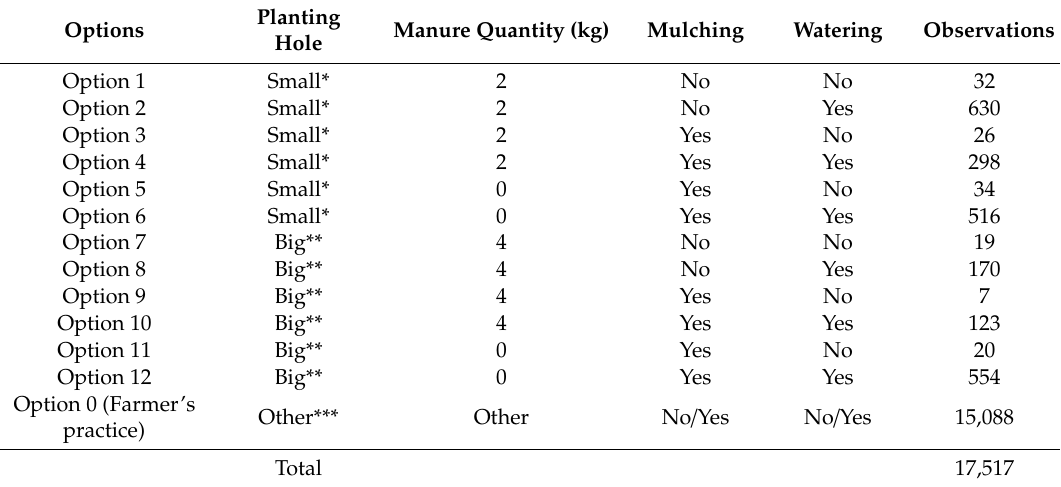
Table 6. Description of options derived from a combination of those tested in